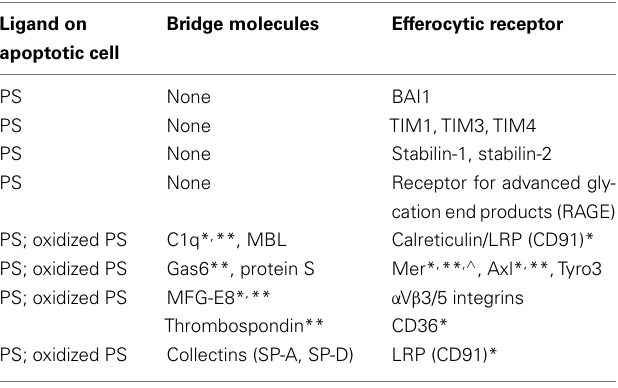
Table 1 | Phosphatidylserine, bridge molecules, and receptors for apoptotic cells including those known to be modulated by nuclear receptor